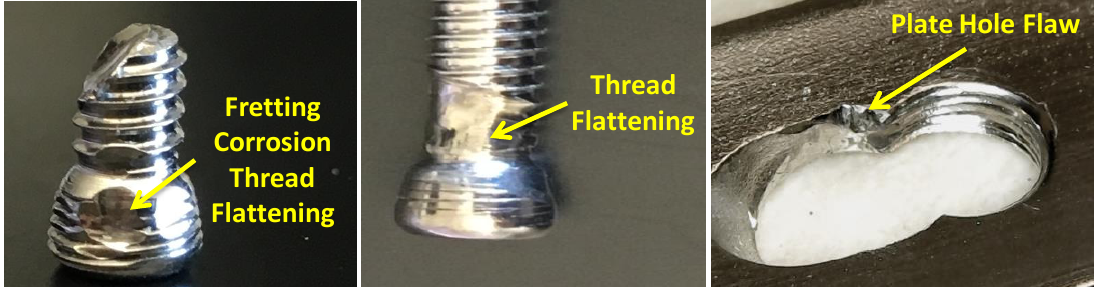
Figure 8. Thread flattening was observed on locking screws ( left, middle ) and plate hole flaw ( right ).